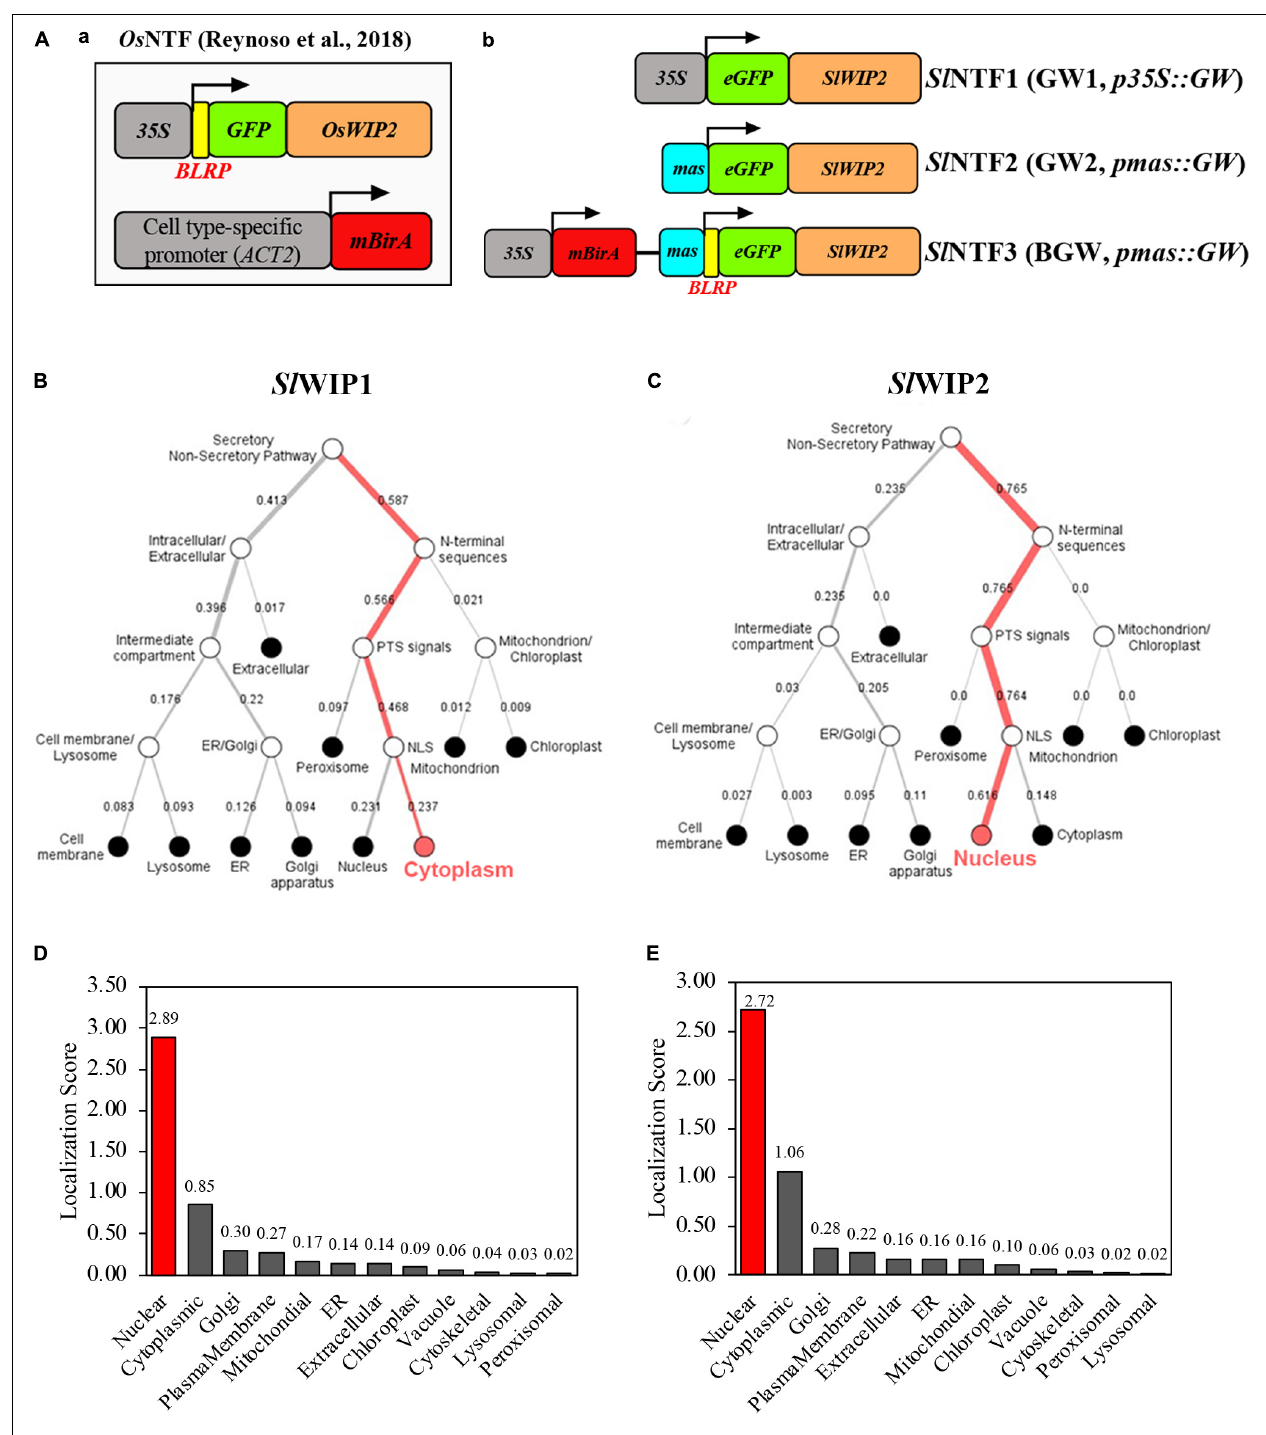
FIGURE 1 | Diagram of three different Sl NTF proteins and their localization prediction. (A) Three modified nuclear tagging fusion (NTF) proteins were used in this study. Conventional NTF (left) designed in Oryza sativa L. ( Os NTF) was consisted of three fundamental units: a C-terminal region of Os WIP2 protein for targeting to the surface of the nuclear membrane, a GFP for observation, and a biotin ligase target peptide along with BirA system for biotinylation of the nuclear envelope. Three retooled NTF proteins were shown (right), namely, p35S:eGFP-SlWIP2 (GW1), pmas:eGFP-SlWIP2 (GW2), and BGW, which was composed of BirA system and GW2 in a common vector. (B,C) Localization prediction of different WPP-interacting protein (WIP) proteins in S. lycopersicum using bioinformatic deep learning methods (https://services.healthtech.dtu.dk/service.php?DeepLoc-1.0). (D,E) Subcellular localization prediction of GW2 and BGW with CELLO2GO (http://cello.life.nctu.edu.tw/cello2go/).